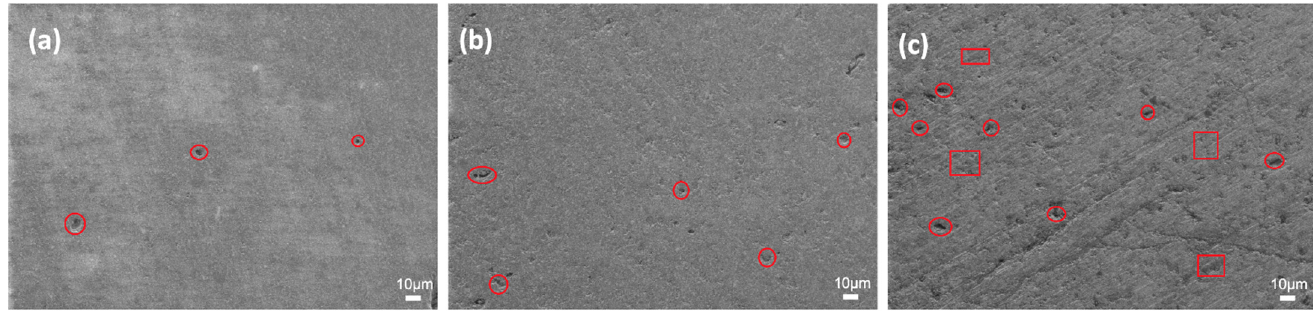
Figure 6. SEM images of the sintered glass-ceramics at 1.00 KX: ( a ) 30Zr-Ar, ( b ) 40Zr-Ar, and ( c ) 50Zr-Ar.